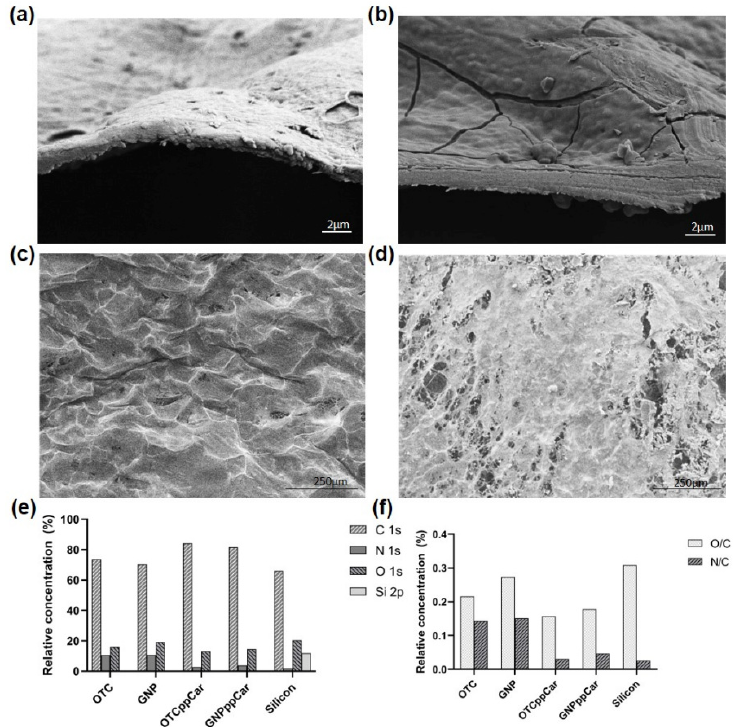
Figure 2. ( a ) Cross-section of FESEM OTC surface before carvone plasma polymerisation (ppCar); ( b ) cross-section of FESEM OTCppCar surface shows the antibacterial carvone coating; ( c ) the top- surface FESEM OTC shows surface roughness before ppCar; ( d ) depicts porous carvone deposition coated on top surface of OTCppCar; ( e ) relative atomic concentrations of carbon, nitrogen and oxygen; and ( f ) ratios of oxygen to carbon (O/C) and nitrogen to carbon (N/C).